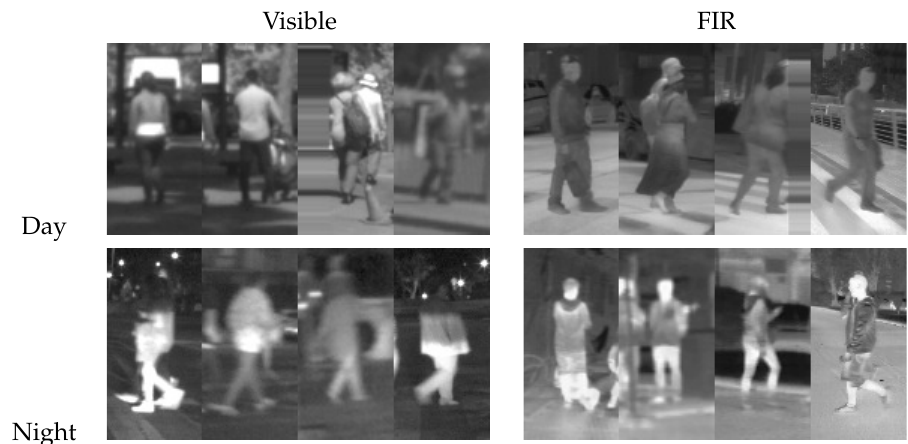
Figure 1. Camera setup for the CVC-14 dataset and registered sample frames showing the different field of views. ( a ) Fields of view of the visible and far infrared cameras and ( b ) example images.